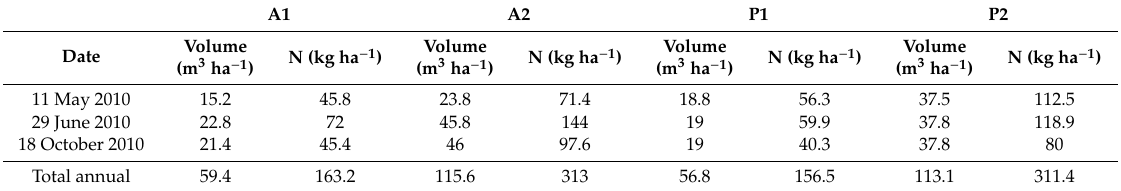
Table 1. Volume and N content from the digestate spreading during the experimental period.